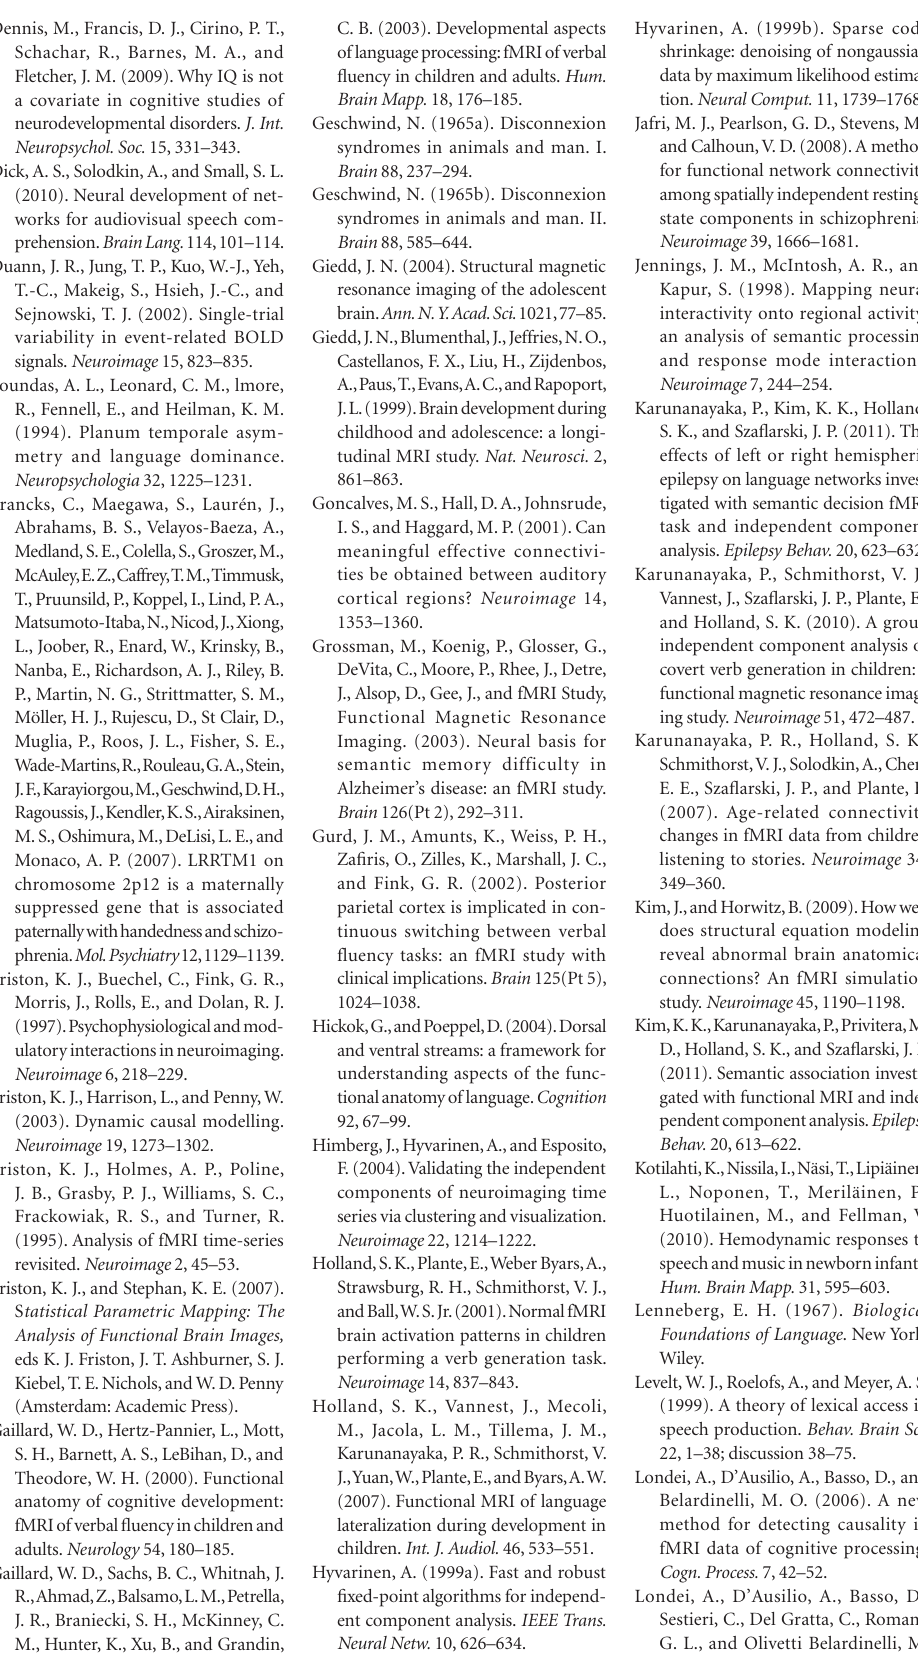
networks in the spectral domain using ICA and Granger causality reveals distinct differences between schizo- phrenia patients and healthy